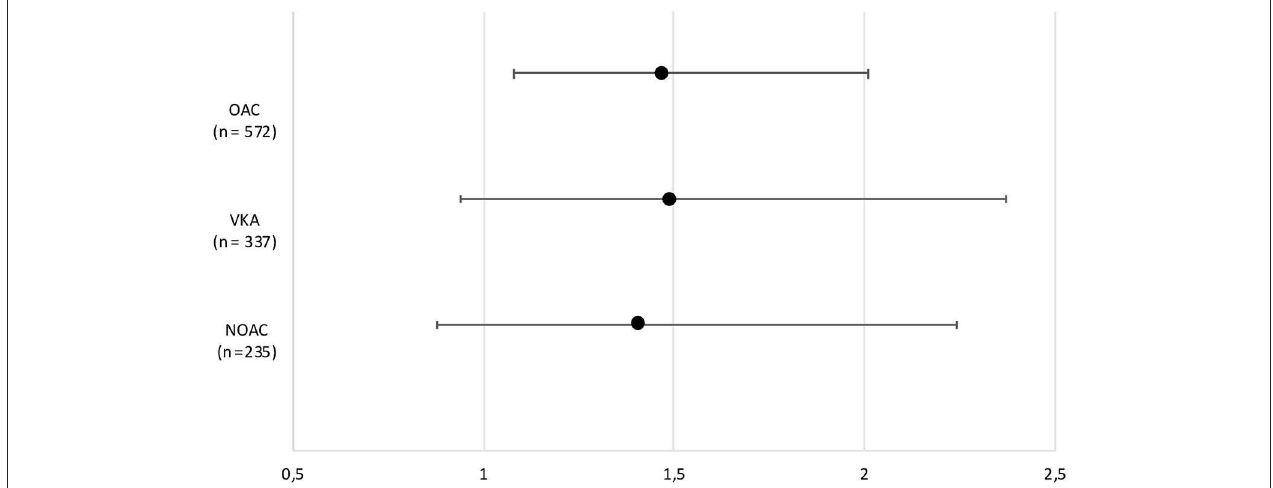
FIGURE 2 | Forest plot demonstrating hazard ratios and confidence intervals for 90-day mortality in patients who did not receive reversal treatment following OAC related ICH, and in subgroup analyses regarding VKA-ICH and NOAC-ICH separately. ICH, intracerebral hemorrhage; VKA, vitamin K antagonist; NOAC, non-vitamin K antagonist oral anticoagulant.